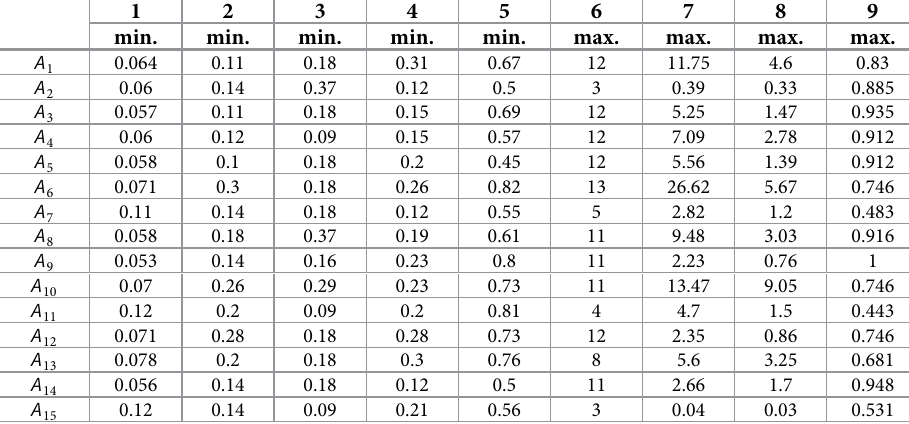
table 1. MOORA applied to 9 objectives for Lithuanian contractors 1a. Matrix of responses of alternatives on objectives: ( x ij ) 1